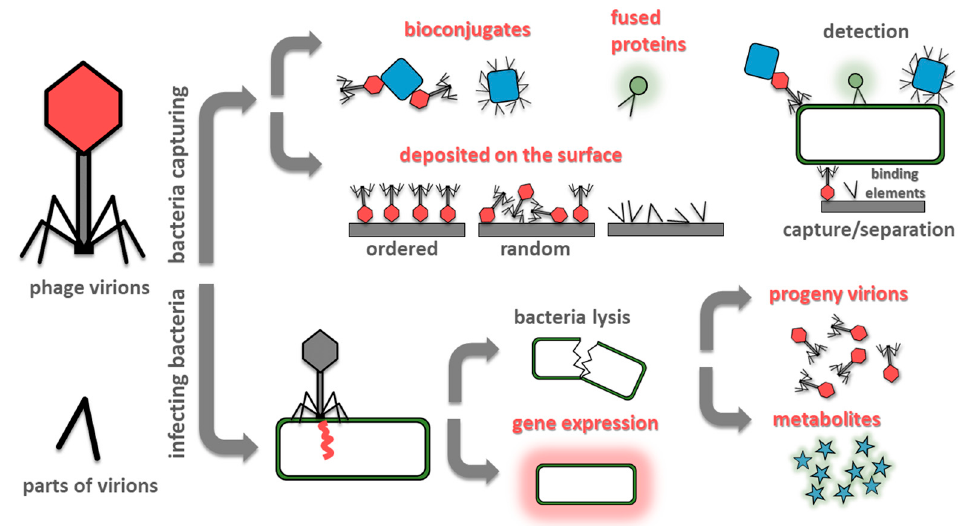
Figure 1. Summary of most often exploited designs of phage-based biosensors. Methods utilizing bacteria capturing (at the surface of the sensing elements or by phage-based probes) are fast. However, a single event generates a signal which is di ffi cult to detect. Contrary, infecting bacteria and utilizing its molecular machinery to amplify the signal (by the generation of progeny virions, introduction reporter genes, or due to release of bacterial metabolites due to lysis) o ff ers lower detection limits, but the procedures are lengthy.